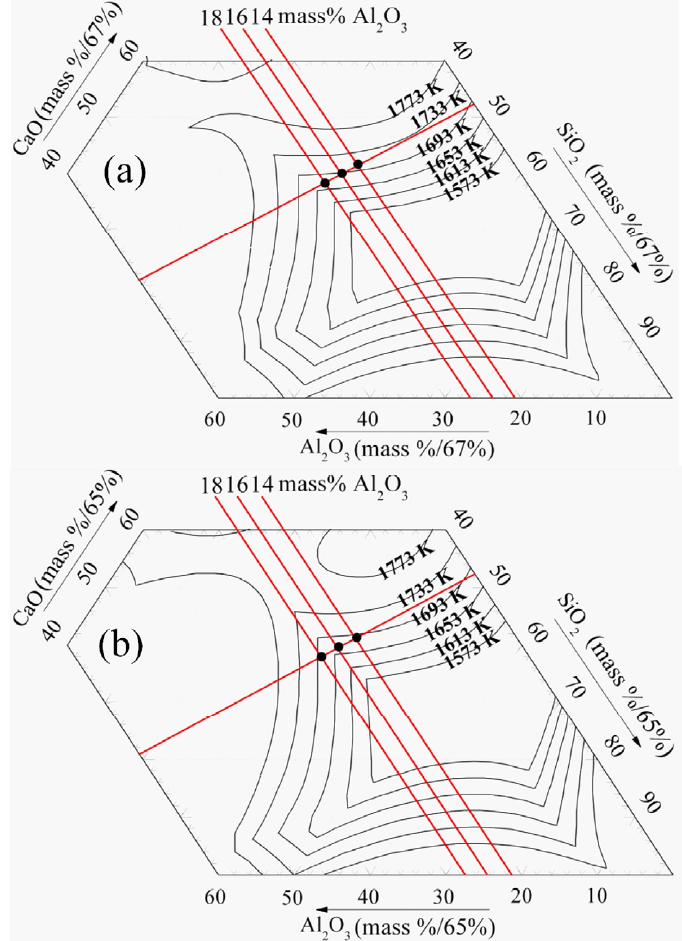
Figure 8. Phase diagram of CaO–SiO 2 –MgO–Al 2 O 3 –25 mass% TiO 2 slag, K. ( a ) 8 mass% MgO; ( b ) 10 mass% MgO.